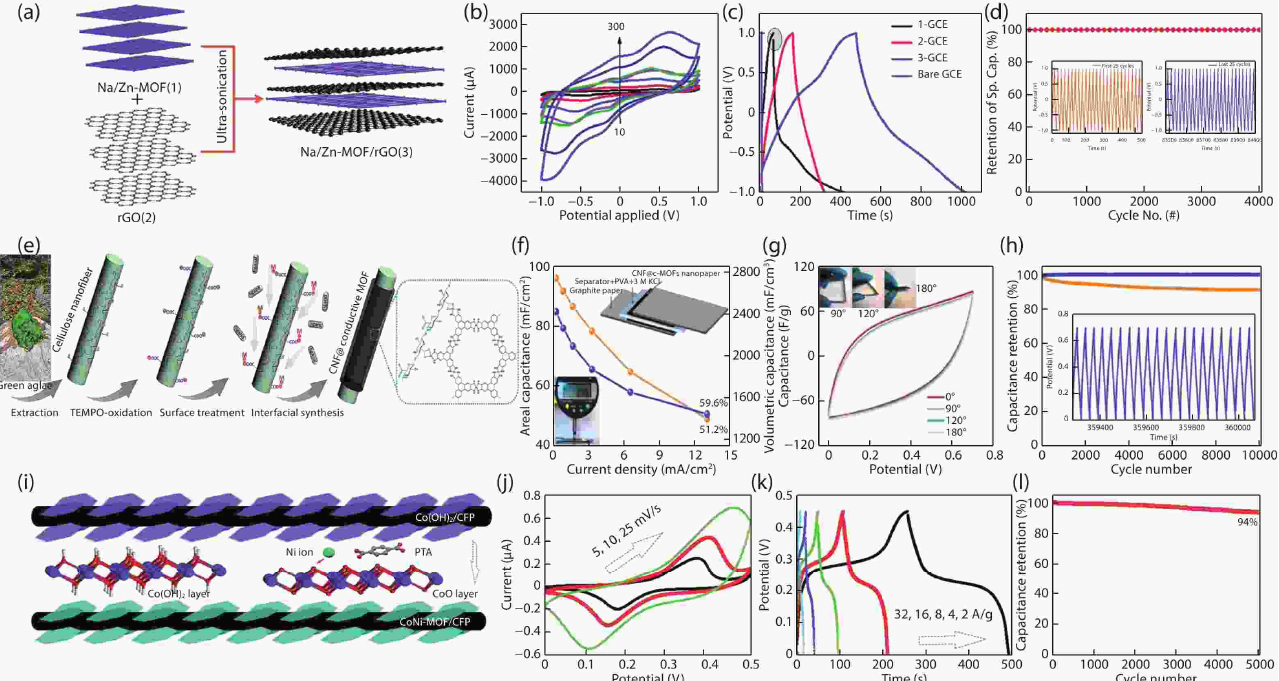
Figure 23. Typical examples of MOFs with assistance components for supercapacitor. ( a ) Schematic diagram of Na–Zn–MOF/rGO. ( b ) The cyclic voltammograms (CV) collected of Na–Zn–MOF/rGO electrode. ( c ) A comparison of the GCD curves of a bare GCE, 1-GCE, 2-GCE, and 3-GCE. ( d ) Cycling stability analysis of Na–Zn–MOF/rGO over 4000 cycles (the left and right insets show the first and last 25 cycles). ( e ) Schematic of the synthesis procedure for the CNF@MOF hybrid nanofibers. ( f ) Calculated areal capacitances of the device at different current densities within 0–0.7 V (blue curve) and 0–1.0 V (orange curve). ( g ) The CV curves at scan rate of 100 mV/s under different folding angles. ( h ) Cyclic performance and capacitance retention data of the device within 0–0.7 V (blue curve) and 0–1.0 V (orange curve). ( i ) The schematic illustration of the strategy to synthesize CoNi–MOF/CFP. ( j ) CV curves of CoNi–MOF at a scan rate of 5, 10, and 25 mV/s. ( k ) Galvanostatic curves collected at a current density of 2, 4, 8, 16, and 32 A/g. ( l ) The cyclability of the capacitor over 5000 cycles [102]. Reproduced with permission.